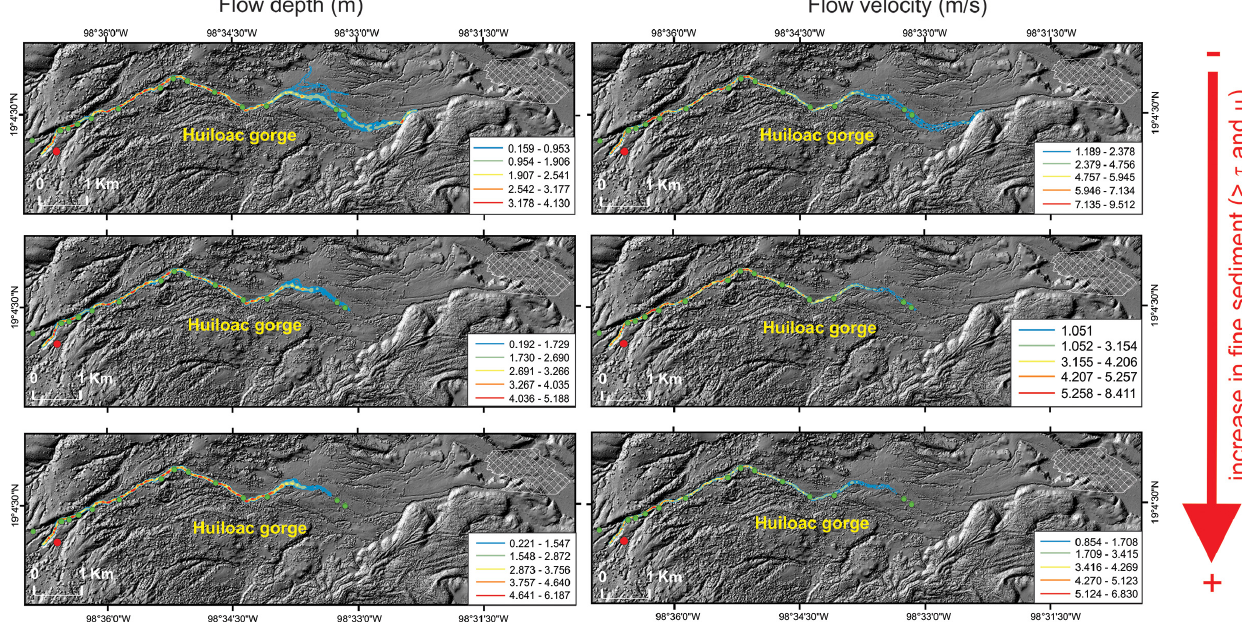
Figure 8. Results of alternative scenarios for lahars with an equivalent volume to the 2001 lahar, but with different sediment concentrations or rheological properties. (a) AS1, more diluted lahar. (b) AS2, lahar with 4.8wt% of clay. (c) AS3, lahar with 6.8wt% of clay. AS2 and AS3 represent high yield strength and more viscous lahars. The first column represents flow depth, the second column, flow velocity. Green circles correspond to field data published by Capra et al. (2004). Red circles are geophone PFM3 from CENAPRED.